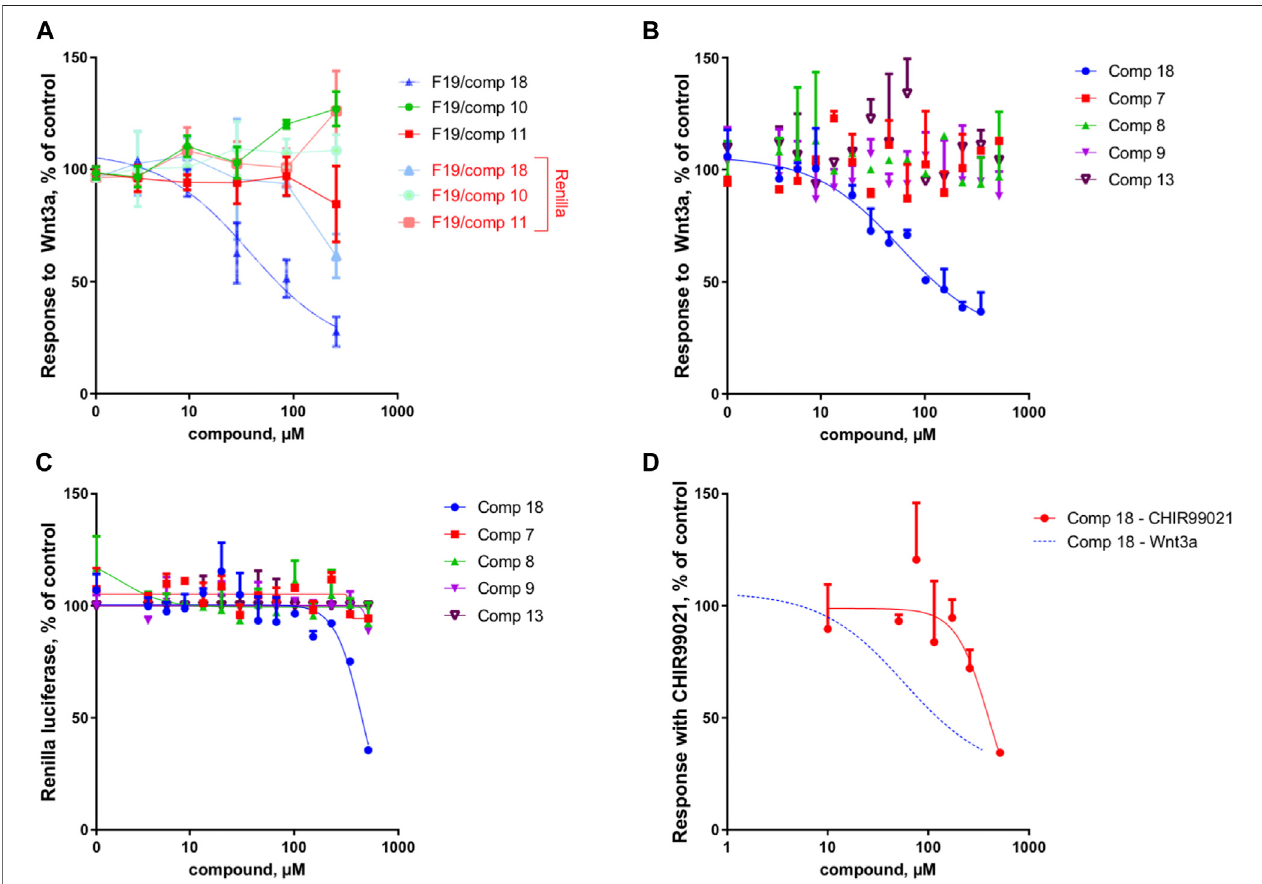
FIGURE 2 | Compound 18 mediates the Wnt inhibition activity at the upstream level of the pathway. (A) Response to Wnt3a stimulation, in % of control and responseofRenillaluciferasein%ofcontrol(cytotoxicity)ofthethreeconstituentsoffraction 19(10,11,and18). Inthefraction F19,only18isabletoinhibitWntactivity, with cytotoxicity occurring only at high concentrations. (B) Response to Wnt3a stimulation, in % of control of 18 (re-isolated as a second batch) compared to isolated analogs(7,8,9,and13).Only18isabletoinhibitWntactivity. (C) ResponseofRenillaluciferasein%ofcontrol(cytotoxicity)obtainedinthesameexperimentasB. Cytotoxicityoccursonlyathighconcentrationswithcompound18. (D) ResponsewithCHIR99021stimulation,in%ofcontrol.ComparisonofWnt3a-andCHIR99021- induced stimulation of the TopFlash reporter. Inhibition by 18 is highly selective for upstream components of the pathway since the inhibition of downstream activator CHIR99021 occurs only at very high concentrations and is thus unspeci fi c (for comparison, the Wnt3a fi t curve of panel B is shown).